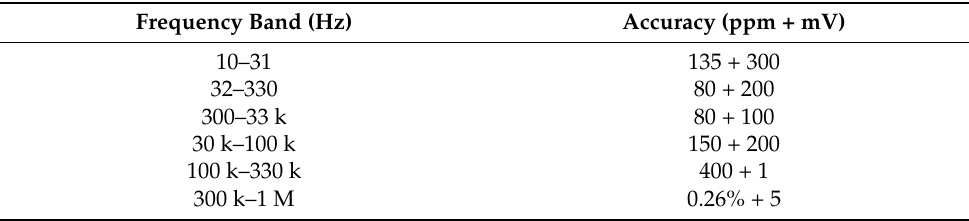
Table 1. Accuracy specifications of the Datron Wavetek 4800 calibrator for a 10 V range.